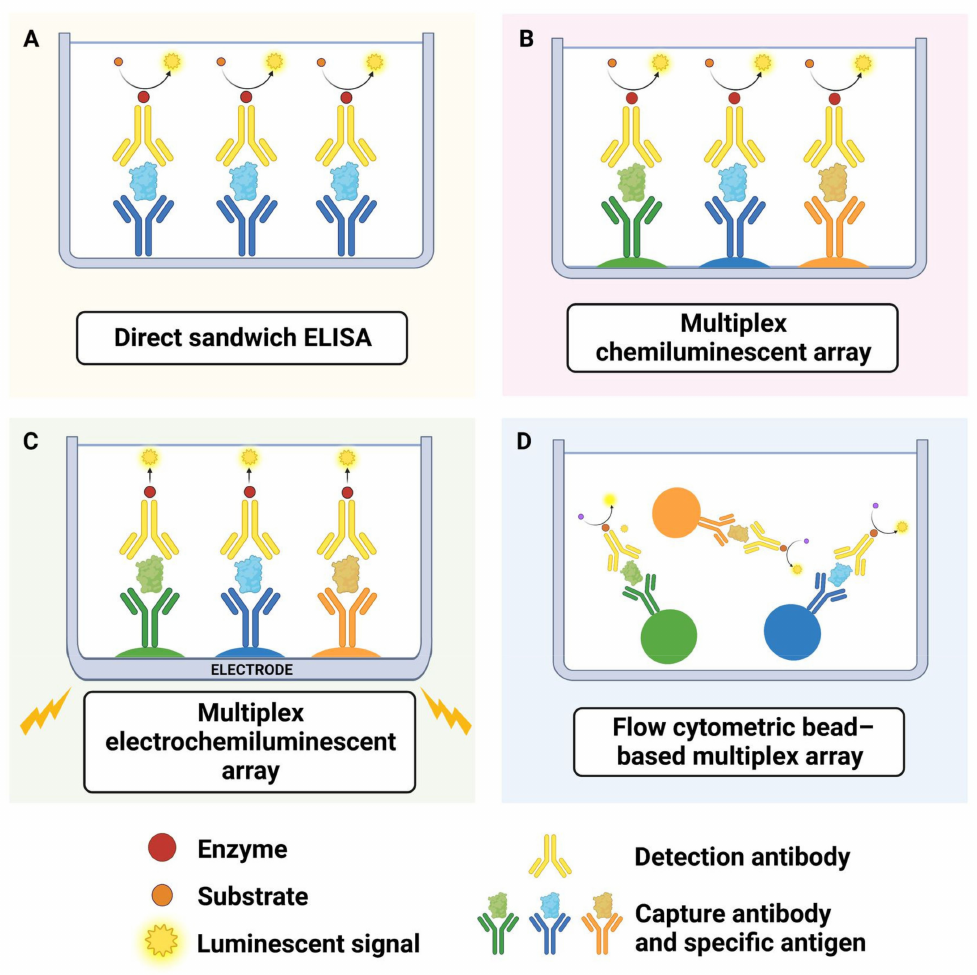
Figure 1. Overview of arrays for quantifying cytokine release. ( A ) ELISA: a 96 well plate is coated with a capture antibody specific to an antigen within the protein of interest, e.g., one specific cy- tokine/chemokine. Next, staining with another antibody that binds to the protein of interest and that is conjugated to an enzyme (e.g., streptavidin/biotin) allows detection/quantification of protein (Kohl and Ascoli, 2017). ( B ) Chemiluminescence arrays: multiple specific biotin-conjugated detection antibodies are added to each well, thus allowing quantification of multiple cytokines following the addition of horseradish peroxidase-conjugated streptavidin and measurement of luminescence. ( C ) Electrochemiluminescence arrays: each detection antibody, instead of being conjugated to biotin, is conjugated to a proprietary tag that is excited with emission beams in the electric field. ( D ) Bead based multiplex arrays: use proprietary bead sets that can be distinguished from each other via flow cytometry (due to varying size/fluorescence of bead types). Each type of bead comes conjugated to an antibody specific to one of the proteins of interest. Next, either streptavidin or fluorescence labelled antibodies are added that bind specifically to each cytokine-antibody complex on the bead sets. Using a flow cytometer, up to 25 cytokines in the same sample can be measured with commercial kits; or up to 100 with custom-conjugation